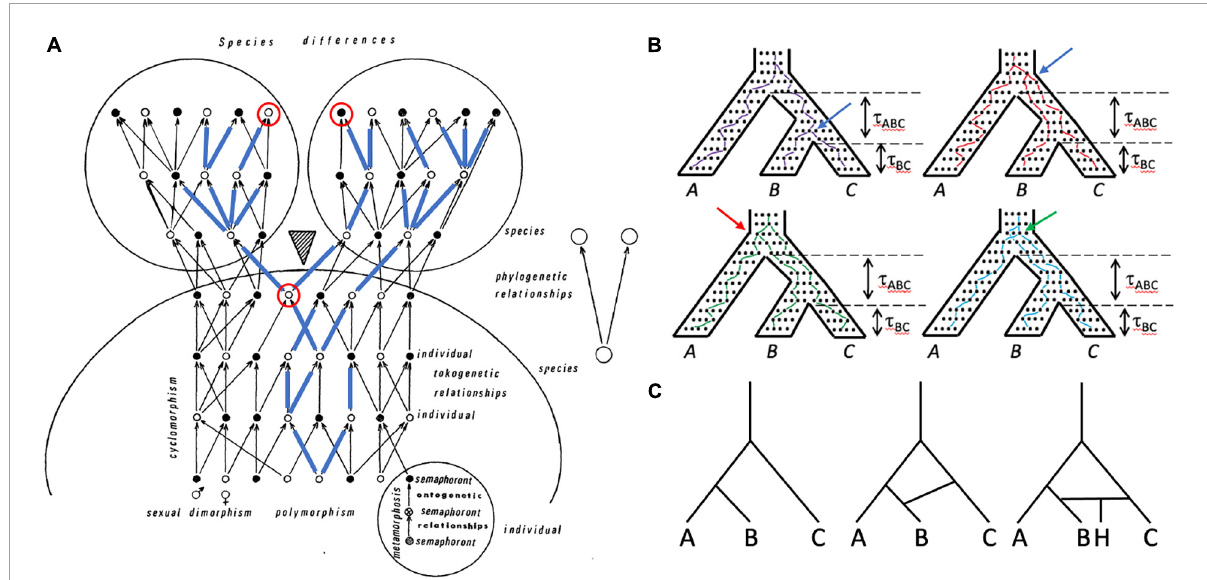
FIGURE3 Lineages of various kinds are important in systematics and can be included within other lineages. (A) Tokogeny and phylogeny (modified from Hennig, 1966). A cladogenic event (shaded triangle) results in the division of a founder species into two sister species. The phylogenetic relationships of the two species are shown in the simple diagram on the right. The larger diagram shows the complexity of reticulate (tokogenetic) relationships of individuals within these polymorphic sexually reproducing species with dimorphic male (black dots) and female (white dots) individuals. Mature individuals are shown, each of which underwent metamorphosis, and thus progressed through several morphologically different character-bearing stages (semaphorants: bottom right circle), which could also provide characters for reconstructing relationships. Cyclomorphism = seasonal variation of individuals, again potentially providing characters if comparable semaphorant stages are sampled. A maternally transmitted mitochondrial DNA lineage is shown in blue lines superimposed on the arrows showing genealogical relationships. Note that although one species is fixed for this mitochondrial lineage, the other species is polymorphic for it, such that some individuals in that species possess mitochondrial genomes that are more closely related to mtDNA in the other species than to mtDNA of individuals in their own species. The mitochondrial genomes of this lineage may not be identical—they can accumulate mutations over time. Looking backward in time from the present (top of diagram), pairs of mitochondrial genomes coalesce at their most recent common ancestor. An example is shown with the two red-circled individuals, one from each species, whose mitochondrial genomes coalesce in the earlier circled individual prior to species divergence. (B) Gene trees are embedded within the species tree, and are shaped by the species history, but gene trees can differ from the species tree both in branch length and topology. The tree for three species with topology (A(B,C)) is shown four times, with individual neutrally evolving alleles shown as dots within it. One allele from each species is tracked backward in time from the present (bottom), with lines randomly connecting alleles in each generation and coalescing with alleles from other species until the common ancestor is reached at the top of the species tree. Time ( t ) in coalescent units (time in generations divided by effective population size) is shown for the two speciation events. Top left: purple lines track an allele coalescent history that closely tracks the species tree, having the same topology (A,(B,C)) and similar divergence times. Top right: red lines track a coalescent history that produces a gene tree topology again identical to that of the species tree, but in which alleles from species B and C coalesce much deeper in the gene tree (compare position of blue arrow in the two trees), which would suggest a much older divergence of species B and C. Bottom left: green lines connect alleles that coalesce to produce a gene tree with topology ((A,B)C), which is incongruent with the species tree; the red arrow shows the coalescence of the species B allele with the species A allele rather than with the species C allele, as in the “purple” gene tree). Bottom right: blue lines connect alleles that coalesce to produce a gene tree with topology (B(A,C)), which again is incongruent with the species tree; the green arrow points to the coalescence of the C allele with the A allele rather than with the B allele. All of the gene trees except the purple tree show deep coalescence of alleles, which in the green and blue trees creates incongruence with the species tree topology through the phenomenon of incomplete lineage sorting (ILS). Tree A has the probability 1–e tABC , whereas each of the other trees has the probability 1/3e tABC . The probability of inferring the correct species tree from trees from individual genetic loci is dependent on t, and thus on effective population size (small populations harbor fewer alleles and afford less opportunity for deep coalescence and ILS) and time (large tABC allows genetic drift to remove variation from the population, minimizing the chance of deep coalescence and ILS). The dependence of gene tree topologies and branch lengths on species history and demography is what allows species histories to be inferred from a sample of gene trees under the multispecies coalescent (MSC). (C) A simple three species phylogeny (left-hand tree) is complicated by introgression or horizontal transfer between species C and D (center tree), and the formation of a hybrid species (H) between species C and D (right-hand